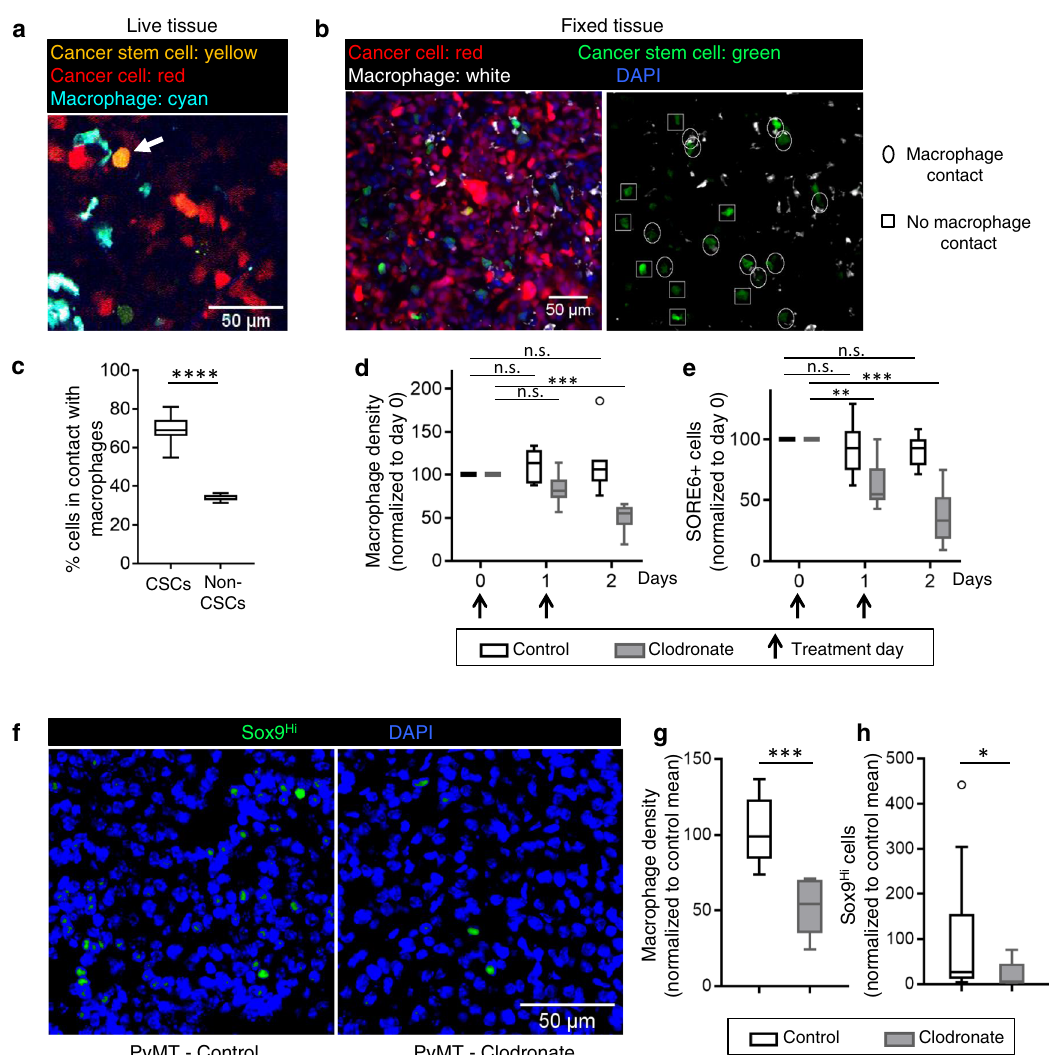
Fig. 3 Macrophages regulate stemness in breast cancer cells. a Intravital microscopy image of a CSC (arrow) in contact with a macrophage in primary tumor in a living mouse. b Left panel: representative images of fi xed-frozen primary tumor tissue showing cancer cell (tdTomato, red), CSC (SORE6 + , green), macrophage (Iba1, white), and nuclei (DAPI, blue). Right panel: same as left but lacking tdTomato and DAPI channels, showing CSCs in contact with macrophages (oval), or not in contact with macrophage (square). c Quanti fi cation of % CSCs and % non-CSCs in direct contact with macrophages or not in live tissue. n = 42 CSCs from 17 fi elds of 340 × 340 µ m 2 in 4 mice, n = 602 non-CSCs from 11 fi elds of 340 × 340 µ m 2 in 3 mice; two-sided Fisher ’ s exact test, **** p < 0.0001. d Quanti fi cation of changes in macrophage density in live mammary tumor over time after control PBS liposome or clodronate liposome treatment. Vertical arrows indicate the treatment days. n = 7 fi elds of 512 × 512 µ m 2 each for control (3 mice) and clodronate (3 mice) treatments. Two-sided Tukey ’ s multiple comparisons test; p -values for control: day0 vs. day1 = 0.44, day0 vs. day2 = 0.67; and for clodronate: day0 vs. day1 = 0.09, day0 vs. day2(clodronate) = 0.0005. e Quanti fi cation of changes in SORE6 + cells in live mammary tumor over time after control PBS liposome or clodronate liposome treatment. n = 7 fi elds of 512 × 512 µ m 2 each for control (3 mice) and clodronate (3 mice) treatments. Two-sided Tukey ’ s multiple comparisons test; p -values for control: day0 vs. day1 = 0.76, day0 vs. day2 = 0.16; and for clodronate: day0 vs. day1 = 0.007, day0 vs. day2 = 0.0007. f Images of PyMT primary tumor tissues treated with either PBS liposomes (control) or clodronate liposomes and stained with Sox9 antibody (green) and DAPI (blue). Image shows Sox9 Hi cells. g Quanti fi cation of changes in macrophage density in fi xed PyMT mammary tumor after PBS (control) or clodronate liposomes treatment every 2 days for 2 weeks. n = 11 (control) and 6 (clodronate) fi elds of 2 – 3 mm 2 tumor tissue from 5 mice (control) and 4 mice (clodronate); two-sided Mann – Whitney test, *** p = 0.0002. h Quanti fi cation of changes in Sox9 Hi cells in fi xed PyMT mammary tumor after PBS (control) or clodronate liposomes treatment every 2 days for 2 weeks. n = 17 (control) and 11 (clodronate) fi elds of 1000 × 500 µ m 2 tumor tissue from 5 mice (control) and 4 mice (clodronate); Mann – Whitney two-sided test, * p = 0.0221. c – e , g , h The boxes indicate 25th – 75th percentile interquartile range (IQR) and central line indicates the median. Top and bottom whiskers were plotted using Tukey ’ s method and extend to 75th percentile + 1.5 × IQR and 25th percentile − 1.5 × IQR, respectively. Points below and above the whiskers are drawn as individual